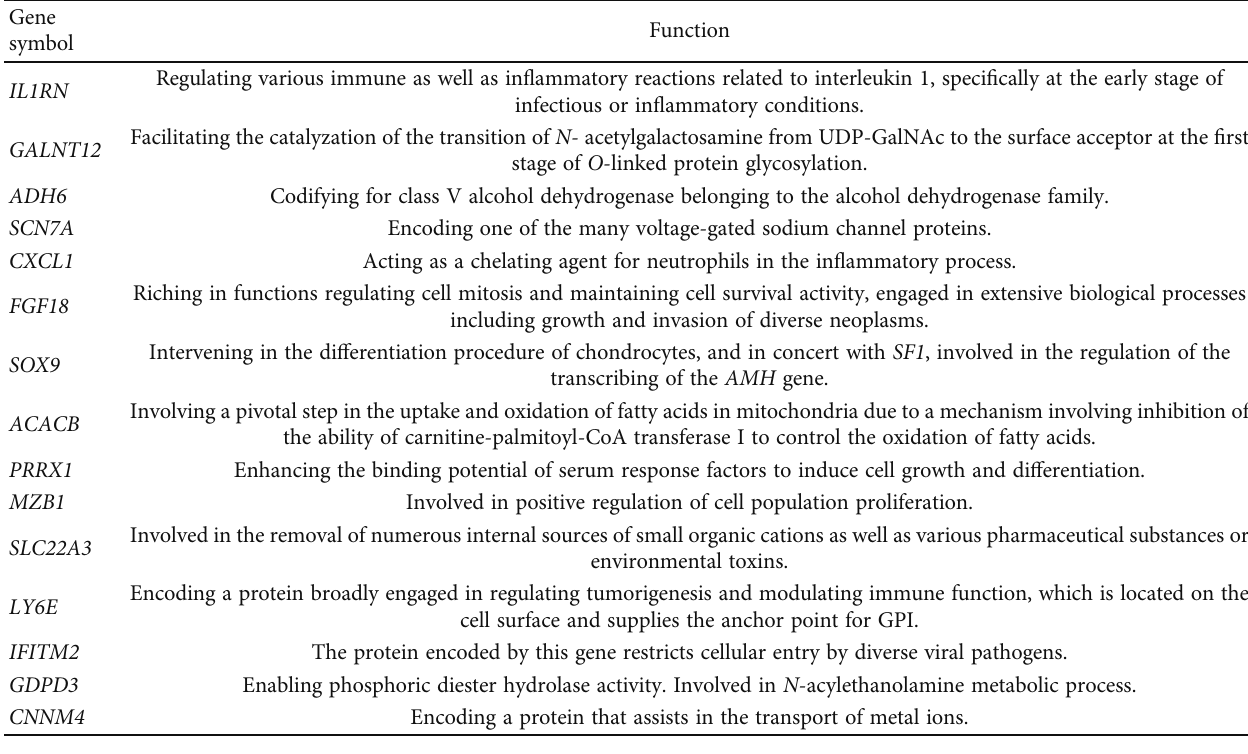
Table 1: Functional roles of 15 seed